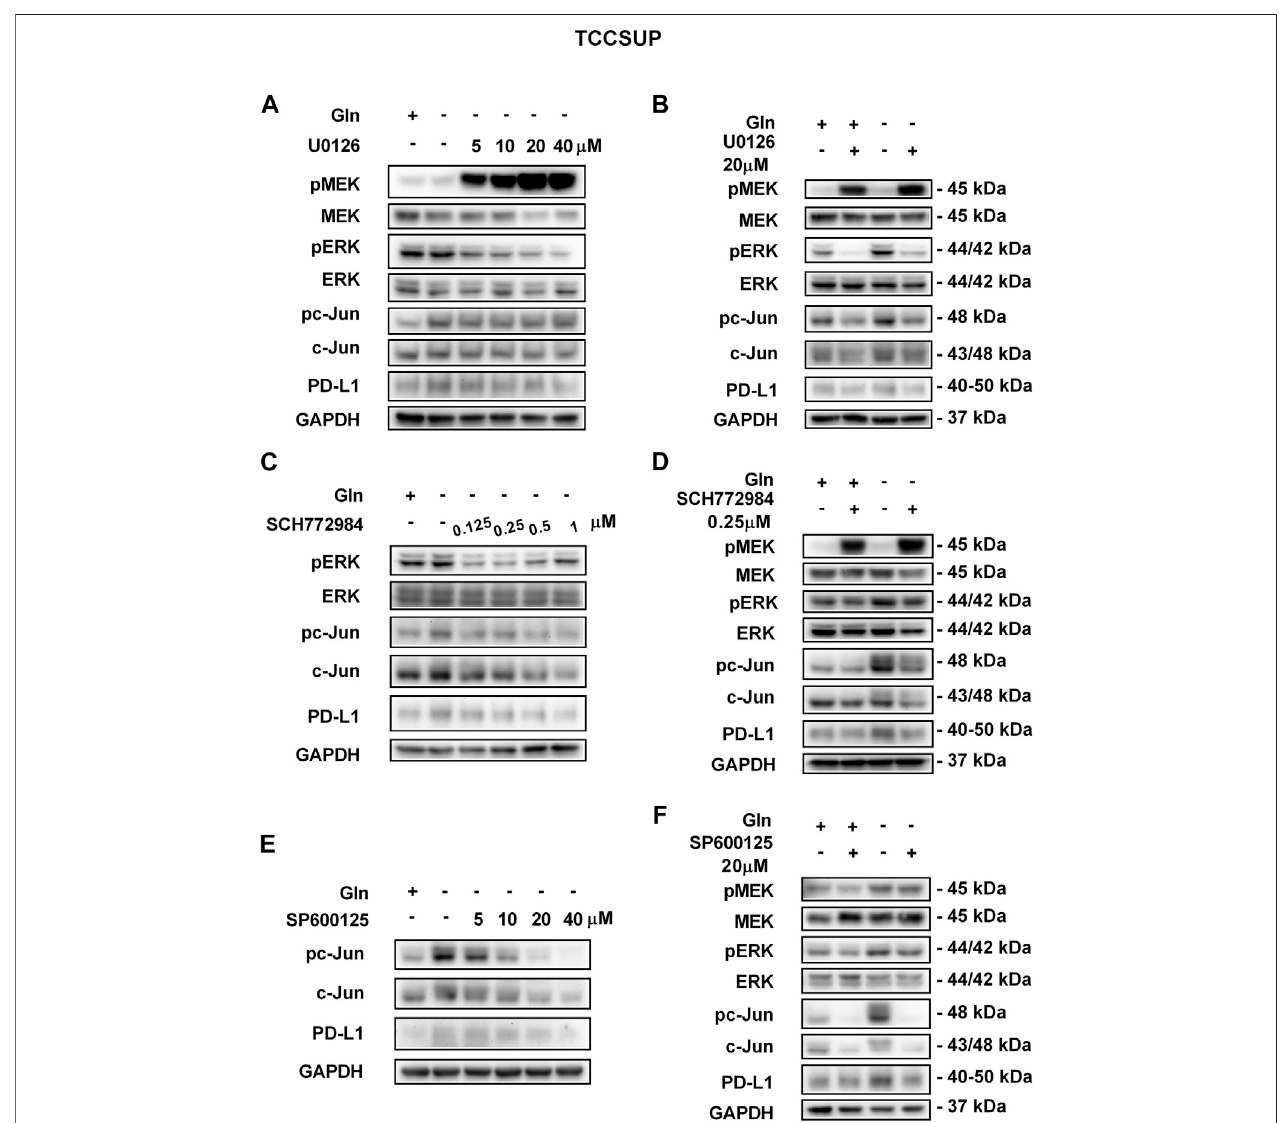
FIGURE 5 | Inhibiting pMEK, pERK or pc-Jun activation can reduce the elevated PD-L1 level induced by glutamine deprivation in TCCSUP cells. (A) The protein levelsofpMEK,pERK,pc-JunandPD-L1inTCCSUPcellsafterculturinginglutamine-freeculturemedium withdifferentconcentrationsofthepMEKinhibitor(U0126:0, 5,10,20,and 40 μ M) for15 h. (B) Theprotein levelsofpMEK,pERK,pc-JunandPD-L1inTCCSUP cellsafter culturinginnormalorglutamine-freeculturemedium with the pMEK inhibitor (20 μ M) for 15 h. (C) The protein levels of pERK, pc-Jun and PD-L1 in TCCSUP cells after culturing in glutamine-free culture medium with different concentrations of the pERK inhibitor (SCH772984: 0, 0.125, 0.25, 0.5, 1 μ M) for 15 h. (D) The protein levels of pMEK, pERK, pc-Jun and PD-L1 in TCCSUP cells after culturing in normal or glutamine-free culture medium with the pERK inhibitor (0.25 μ M) for 15 h (E) The protein expression of pc-Jun and PD-L1 in TCCSUP cells after culturing in glutamine-free culture medium with different concentrations of the pc-Jun inhibitor (SP600125: 0, 5, 10, 20, and 40 μ M) for 15 h. (F) The protein levels of pMEK, pERK, pc-Jun and PD-L1 in TCCSUP cells after culturing in normal or glutamine-free culture medium with the pc-Jun inhibitor (20 μ M) for 15 h.